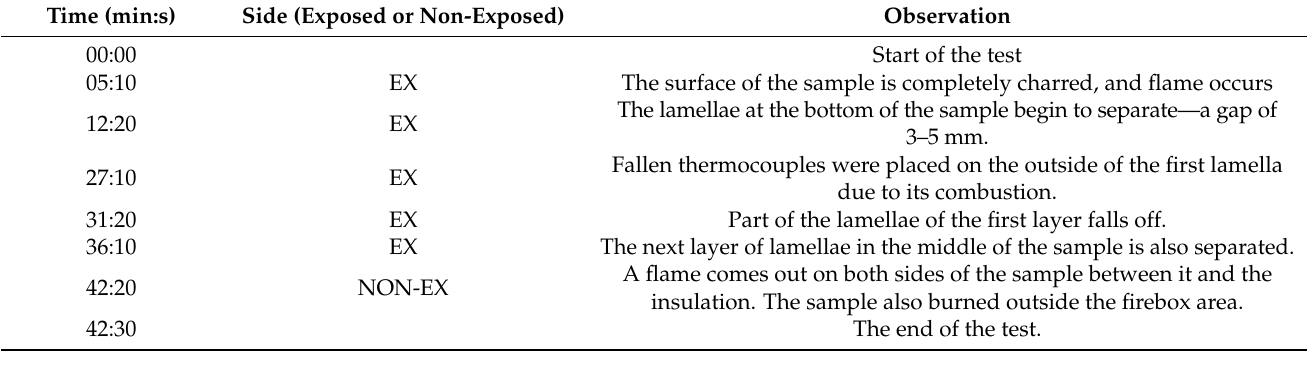
Table 5. Observations during fire testing—normal beam.